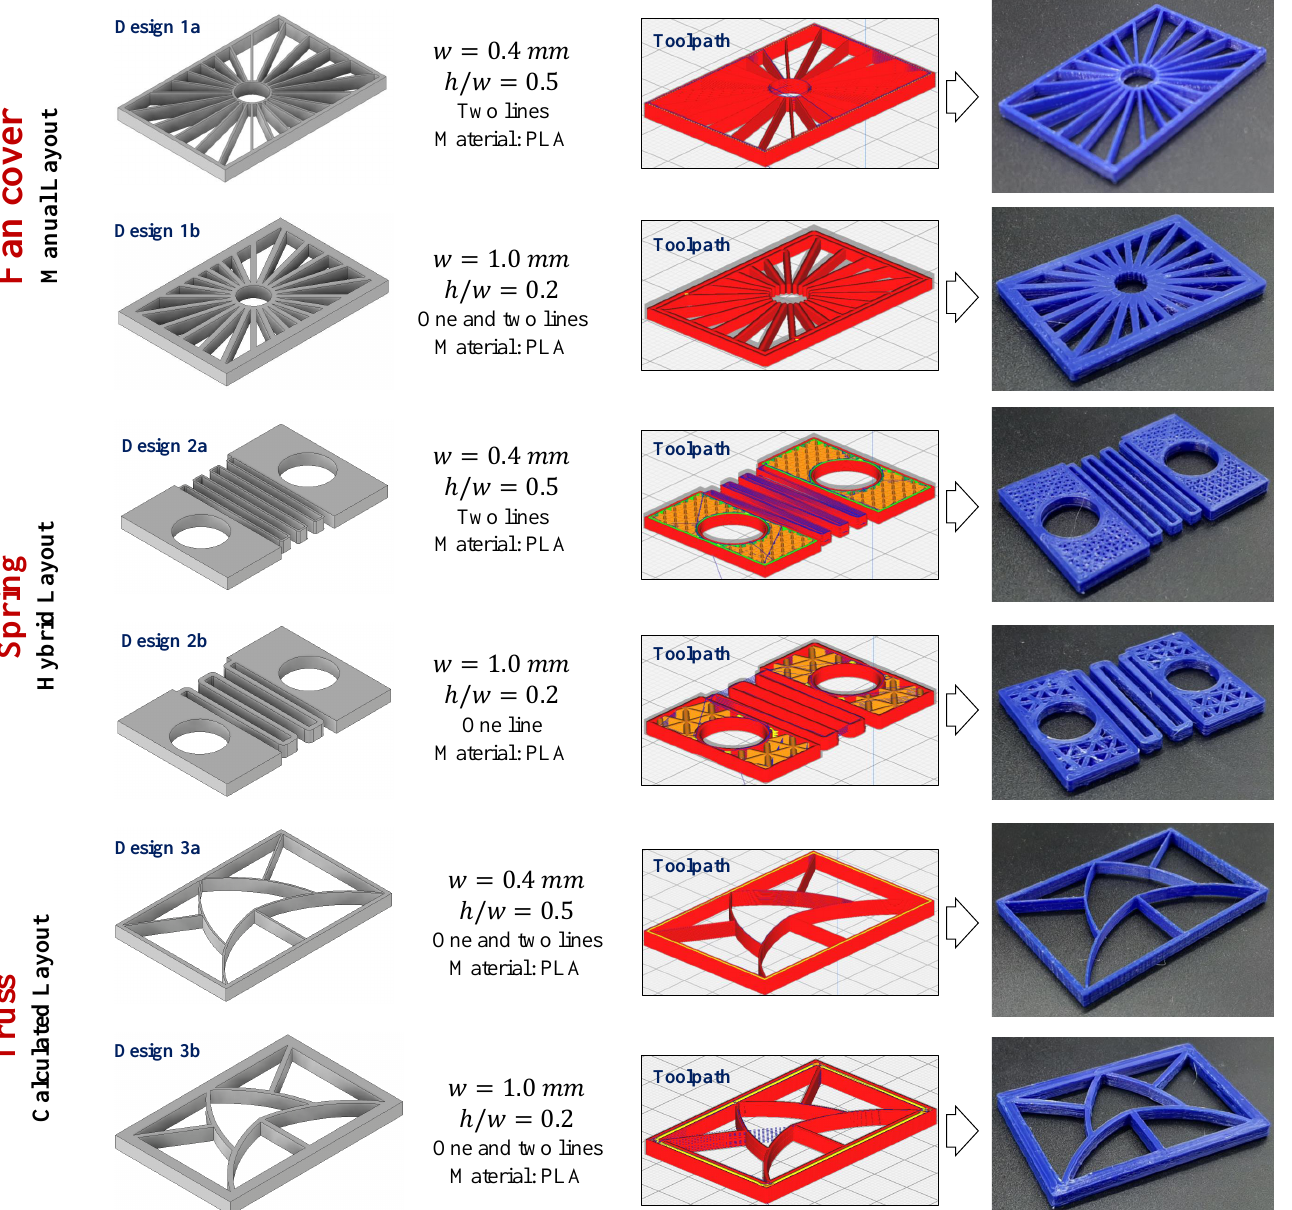
Figure 18. Results of Case Study